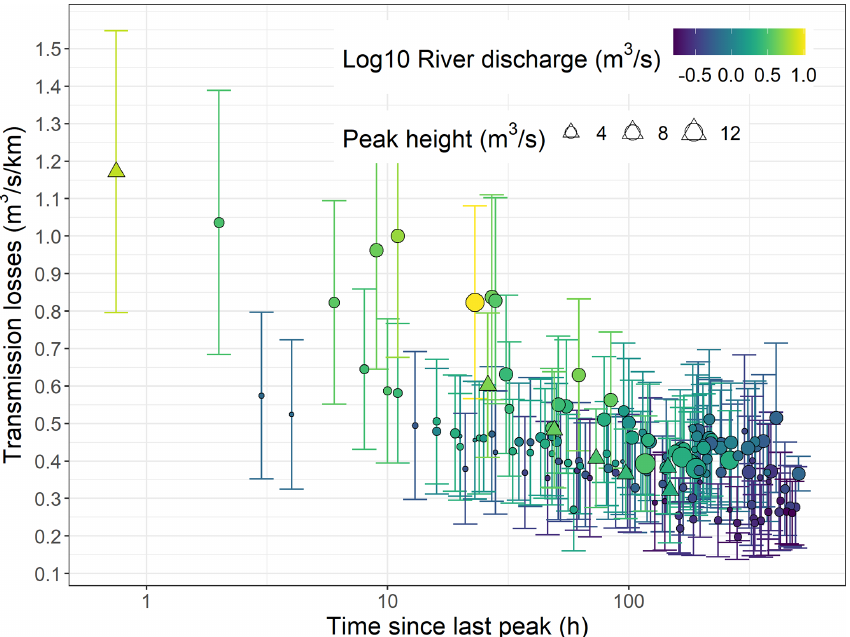
Figure 11. Estimated transmission losses using differential gauging, field GPS points and satellite images as a function of the time since the last peak. The colour scale represents the river discharge (log10 transformed) and the point size scale represents the peak height. Triangles indicate the September 2020 event presented in Fig. 7 and circles the other data